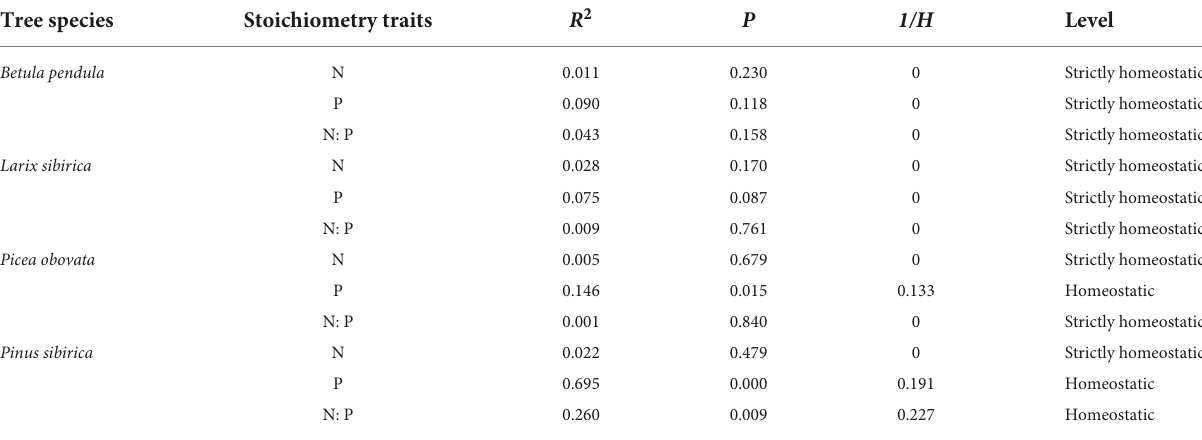
TABLE 2 Homeostatic analysis for the stoichiometry in Kanas natural